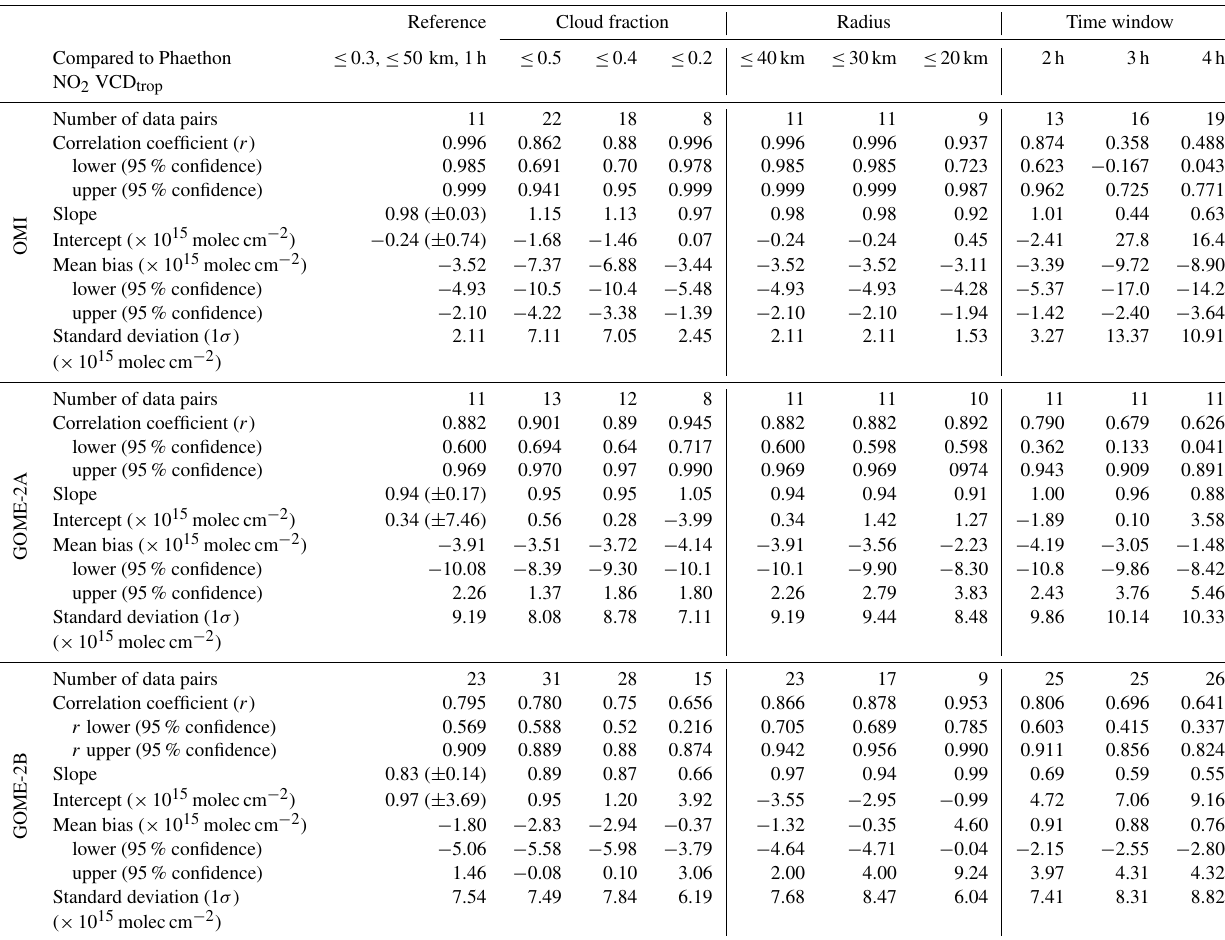
Table 2. Statistics of the comparison of tropospheric NO 2 VCD derived from Phaethon and the three satellite sensors, using the reference coincidence criteria (first data column) and for several different cases of CF filtering, time period around overpass and distance limit between the MAX-DOAS station and the satellite pixel